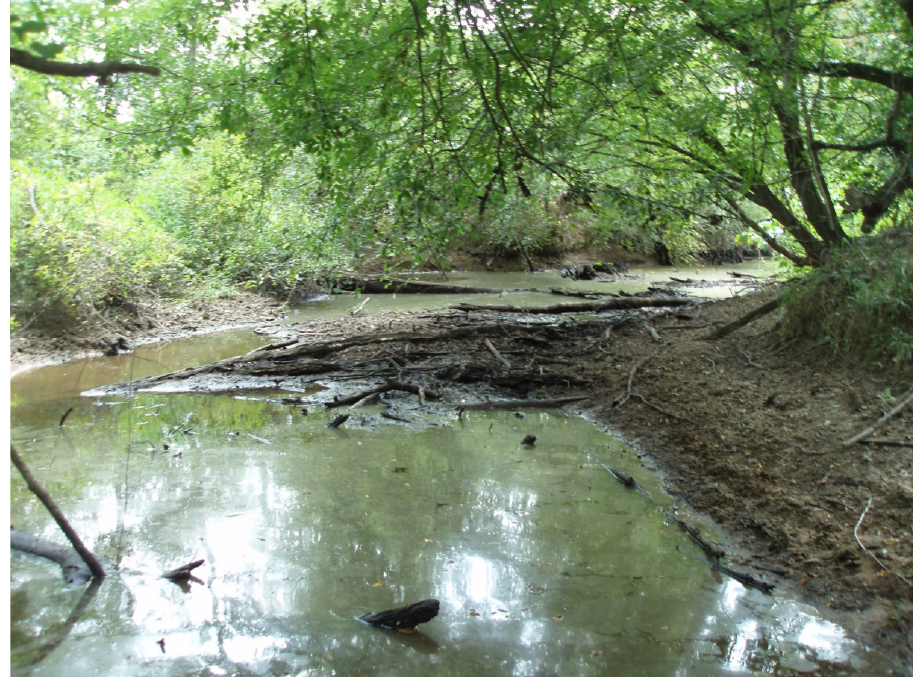
Figure 2. Photo of Turkey Creek, a 2nd-order stream in north-central Louisiana showing typical low-gradient, meandering flow, and high organic conditions.